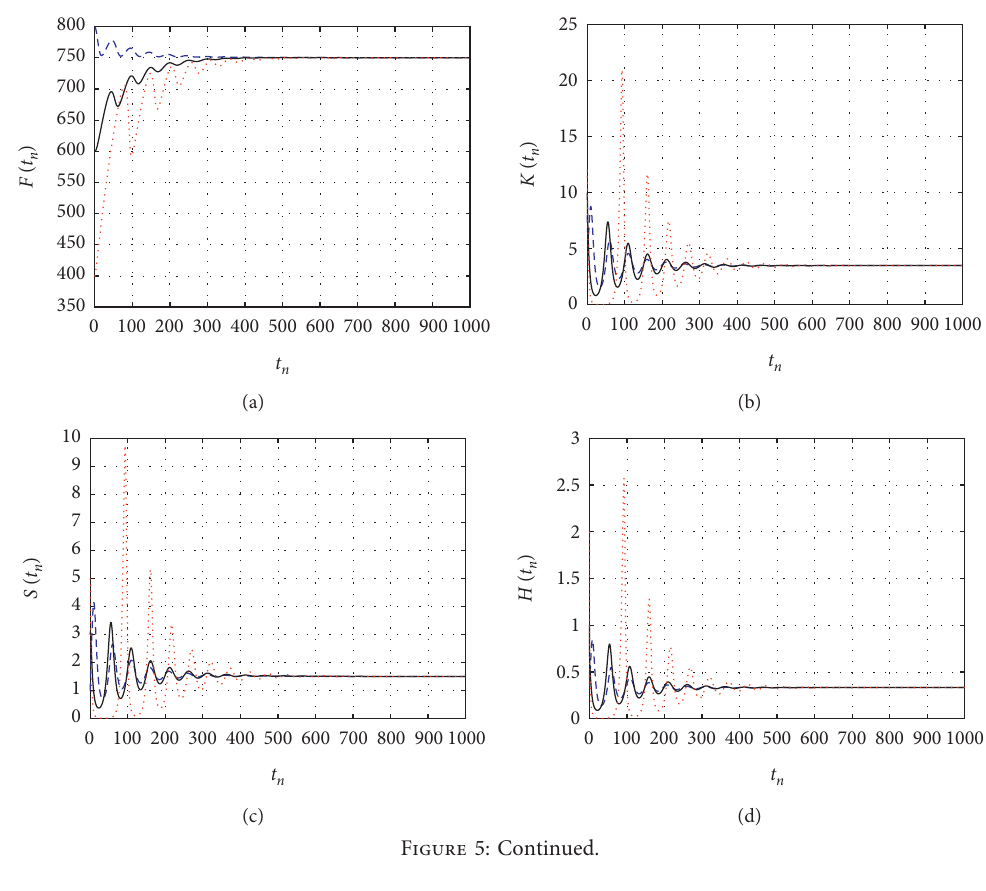
> 1 and R Y / R Z ≤ 1. 1 1 2